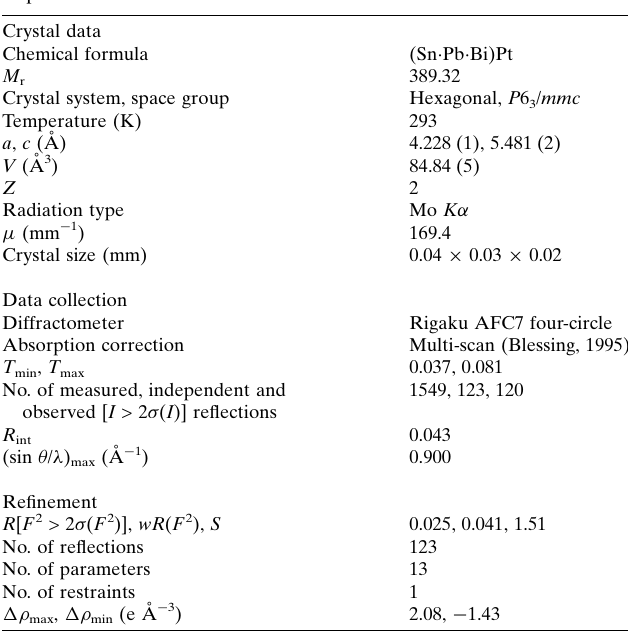
Table 1 Experimental details.